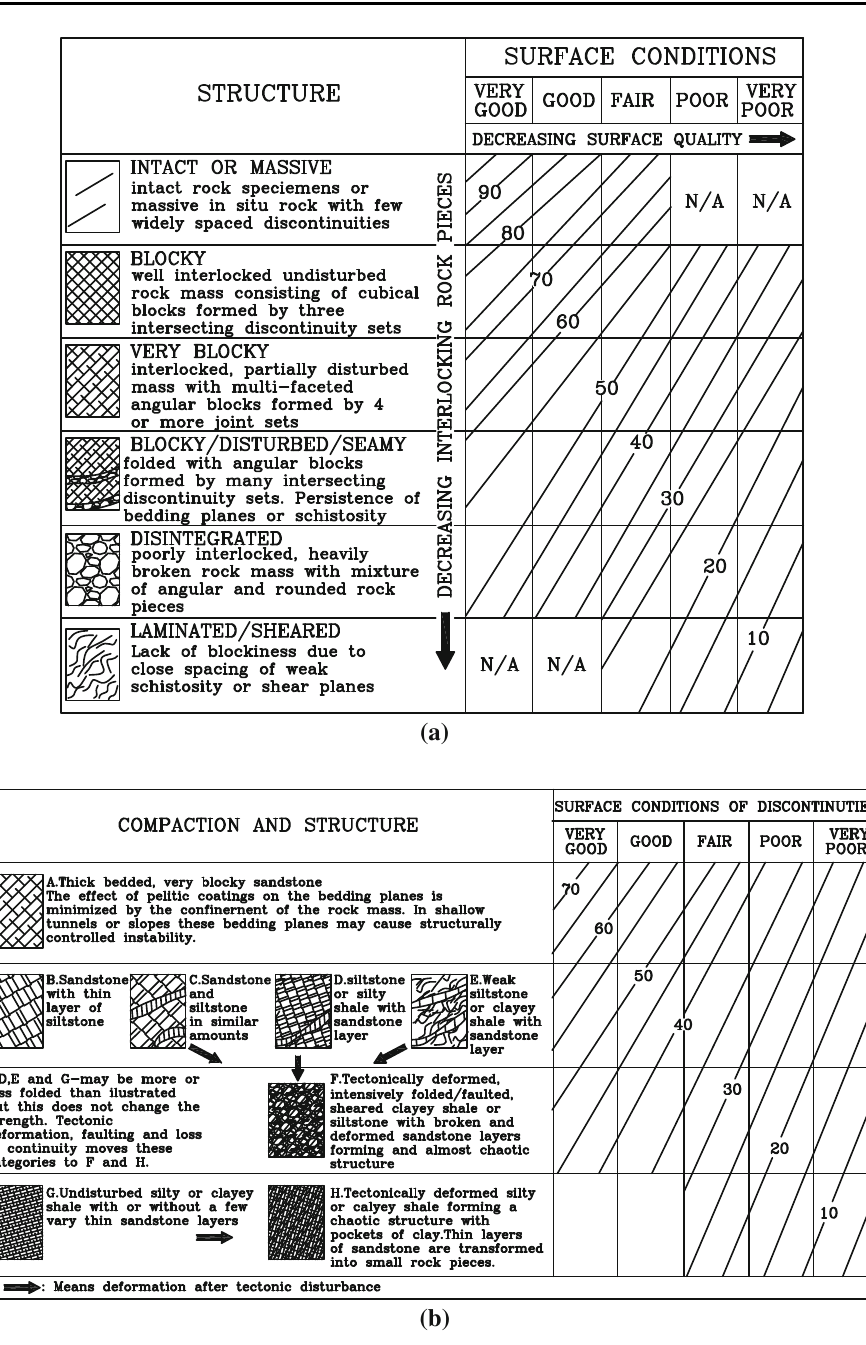
Fig. 1 GSI charts mainly applicable for tunnels ( a ) and for surface excavations and slopes ( b )